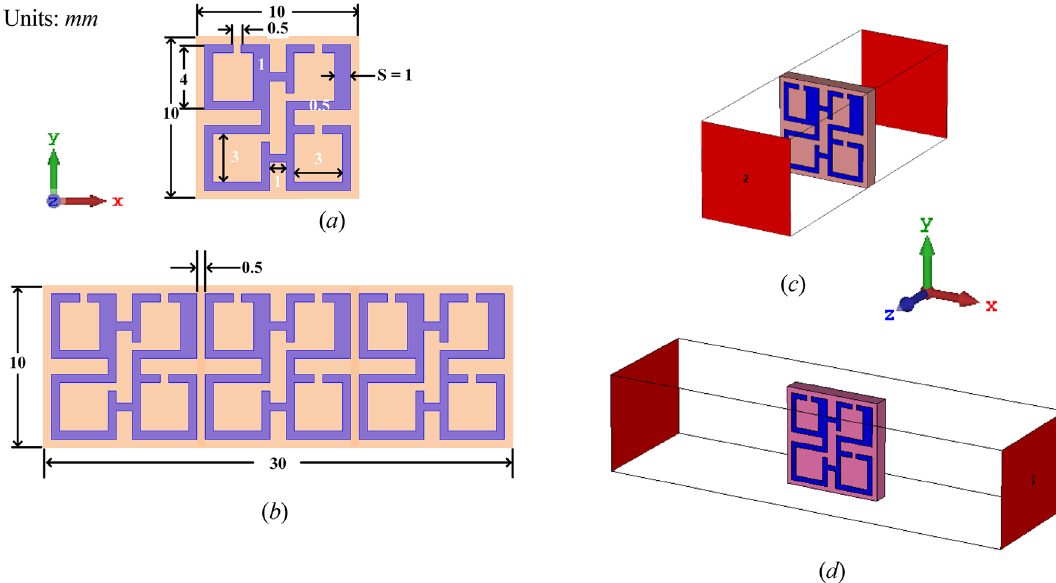
Figure 1. The proposed metamaterial unit cell structure: ( a ) unit cell geometry, ( b ) 3 × 1 MTM unit cell array, ( c ), simulation set up in z-axis, ( d ) simulation set up in x-axis.